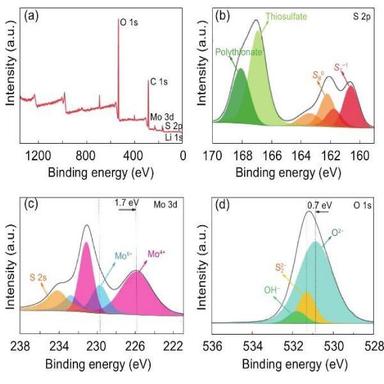
a) Full survey XPS spectrum of the 30MoO2/CNT after discharging, high resolution XPS spectra of (b) S 2p, (c) Mo 3d and (d) O 1s.